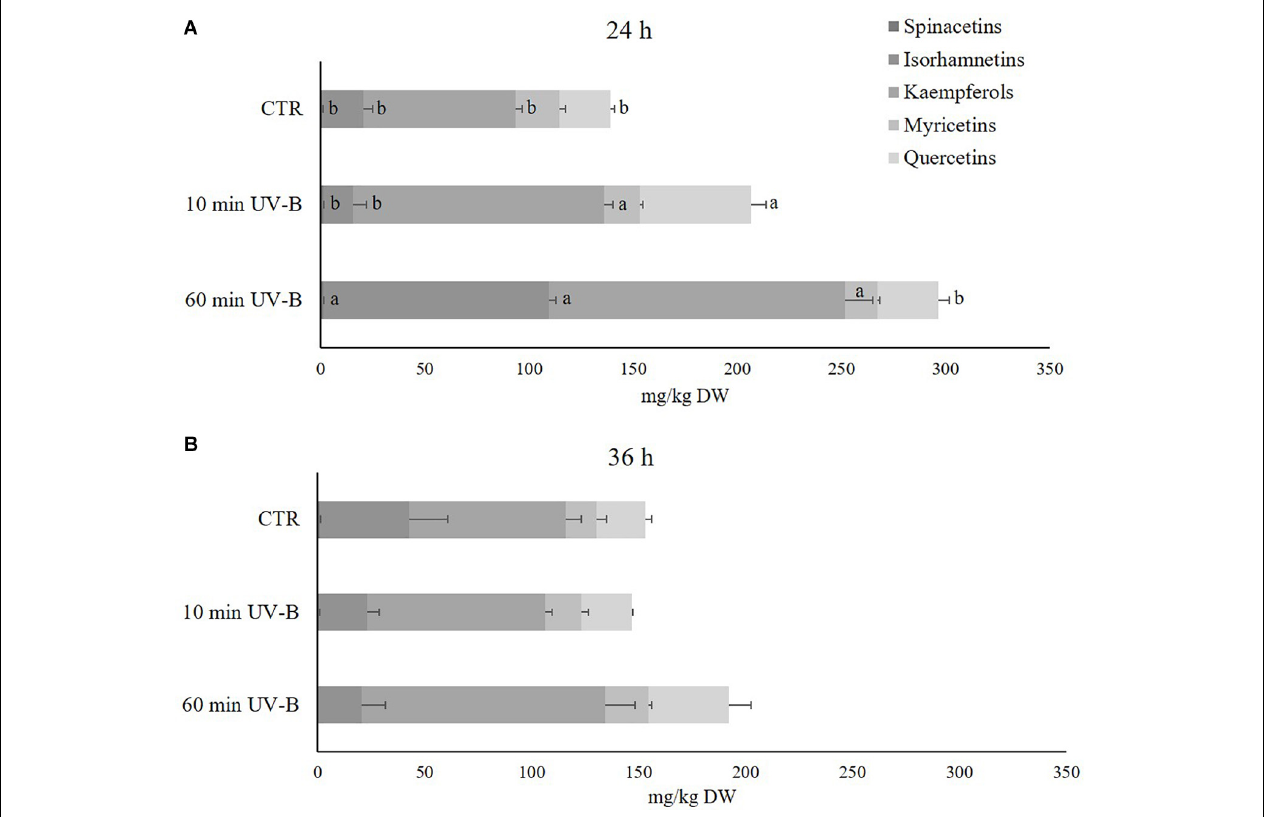
FIGURE 3 | Concentration (mg/kg DW) of different flavonols (spinacetins, isorhamnetins, kaempferols, myricetins, and quercetins) in the pulp of peaches exposed to UV-B radiation for either 10 or 60 min and sampled after 24 h (A) and 36 h (B) from the exposure. Data are mean ± SE of five biological replicates. Different letters correspond to statistically significant differences according to one-way ANOVA followed by Tukey–Kramer post hoc test ( P ≤